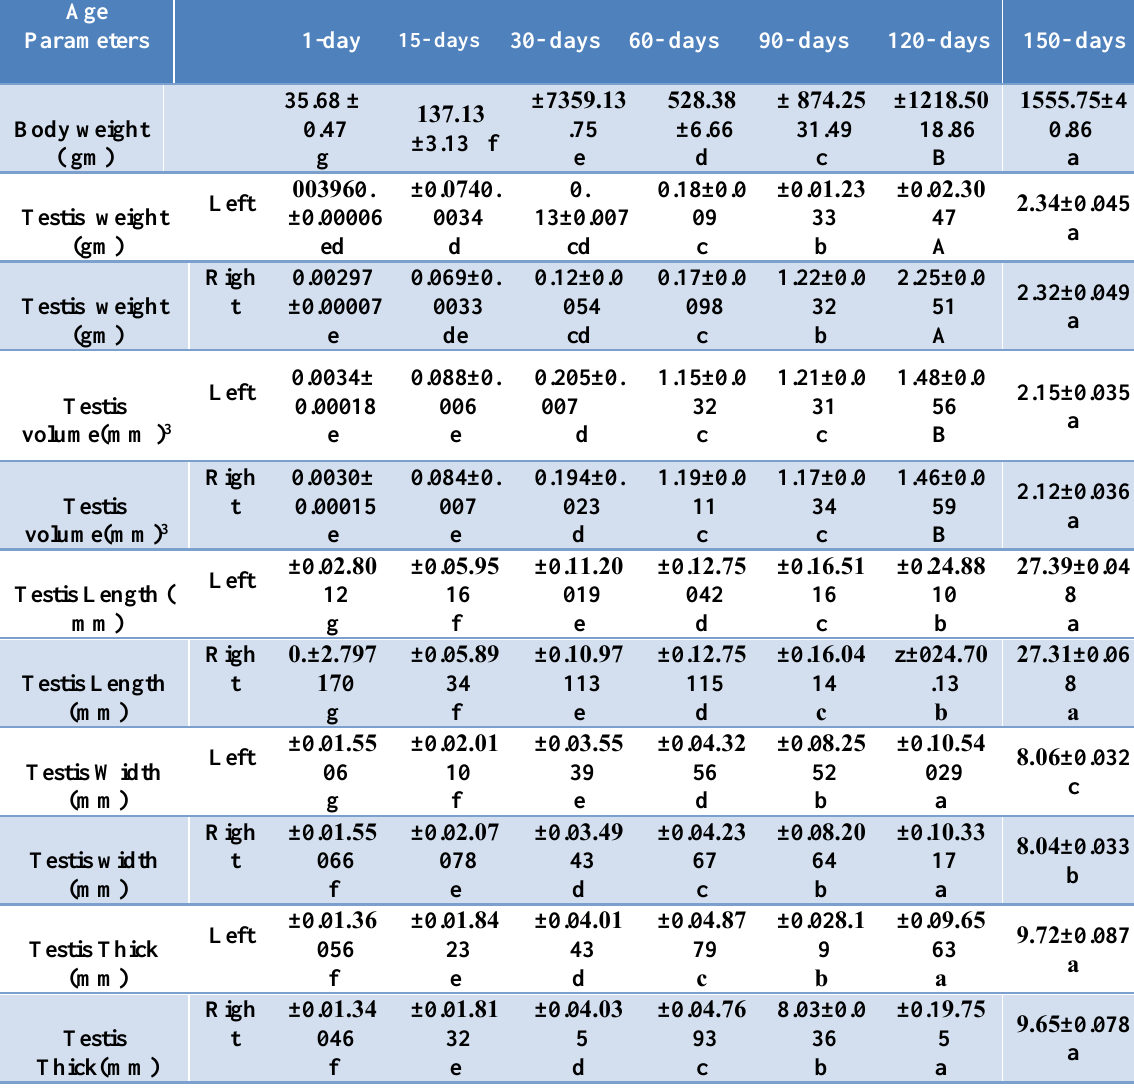
Table, 1: Showing Weights, Volumes, Length, width and thickness of left and right Testes